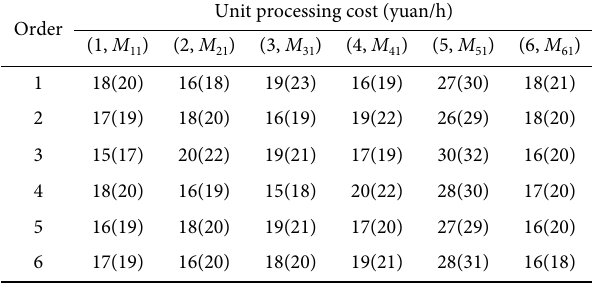
Table 4 Unit processing costs.